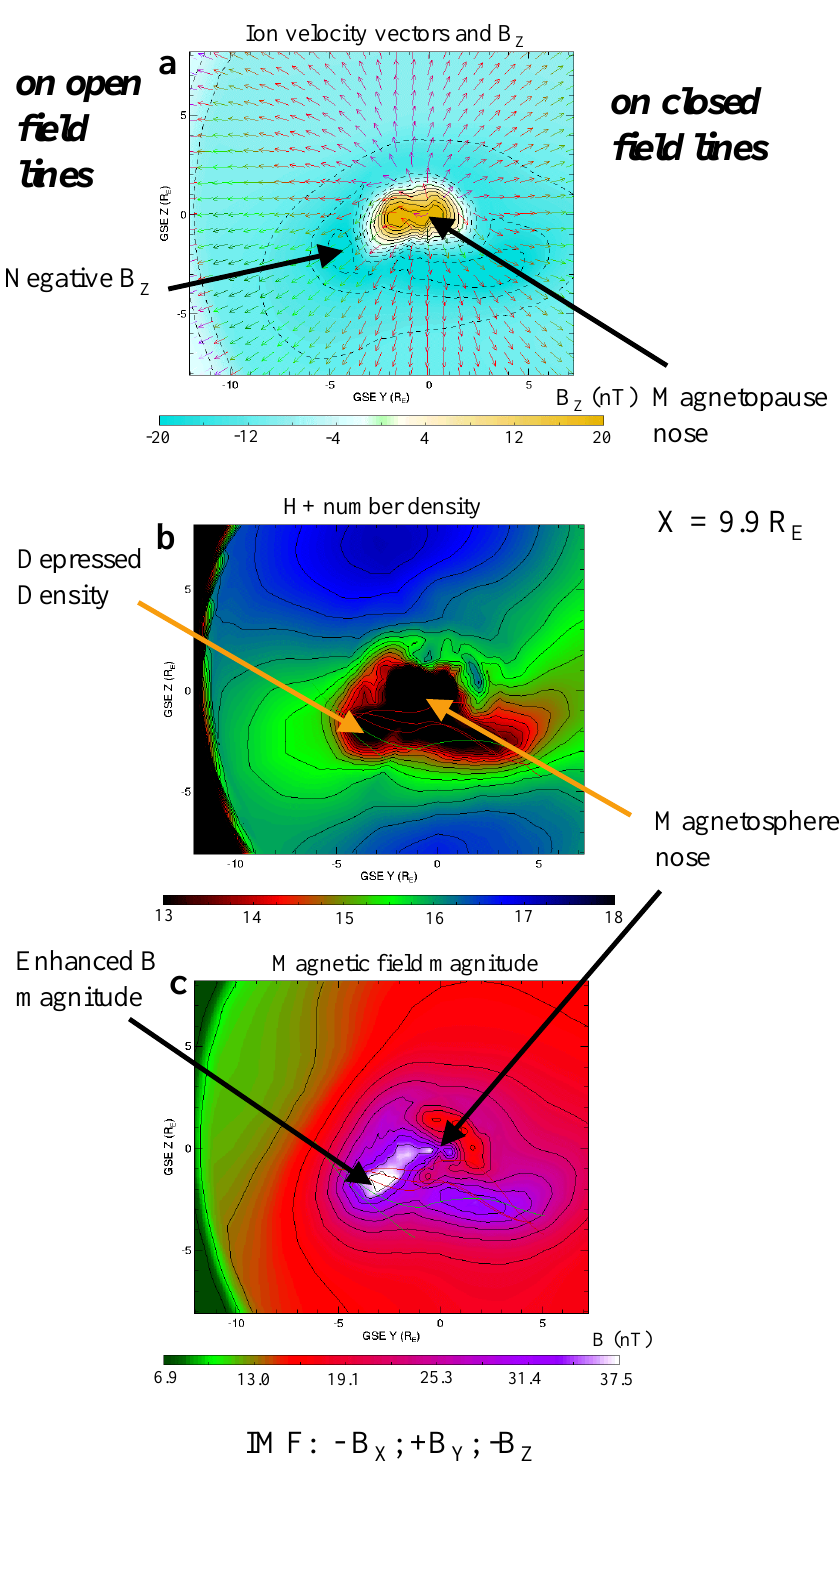
Fig. 4. Results from a MHD sim- ulation with a constant IMF input of equal magnitude negative B X , positive B Y and negative B Z . The simulation output is presented in the YZ plane at X = 9 . 9 R E , which just contacts the nose of the magnetosphere. (a) Veloc- ity vectors are overlaid on the plane colored with B Z . Brown colors indi- cate closed magnetosphere field lines, while blue colors indicate open magne- tosheath or boundary layer field lines. (b) The plane is colored with the pro- ton number density. (c) The plane is colored with the magnitude of the mag- netic field. Attention is called to the region below and to the left of center in each panel, where depressed density and enhanced B are seen on open field